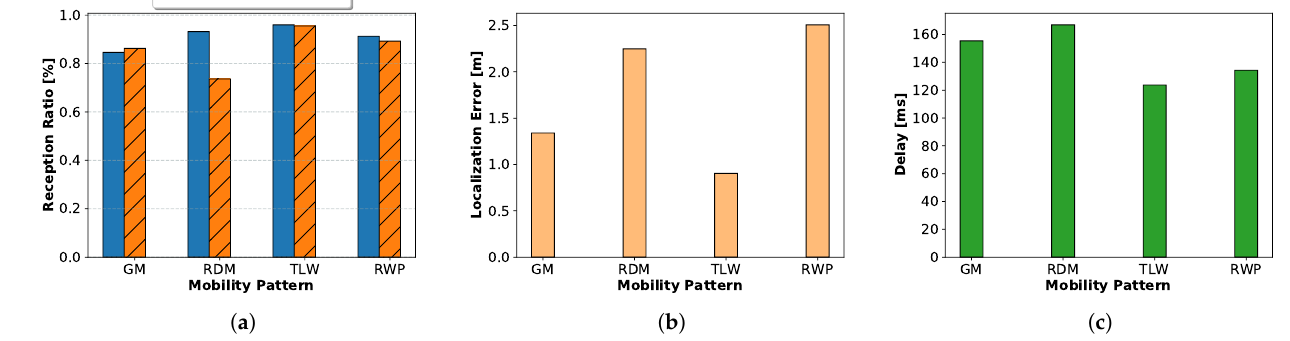
Figure 17. Simulation results for different mobility patterns with SDMob—( a ) PDR; ( b ) localization error; and ( c ) end-to-end